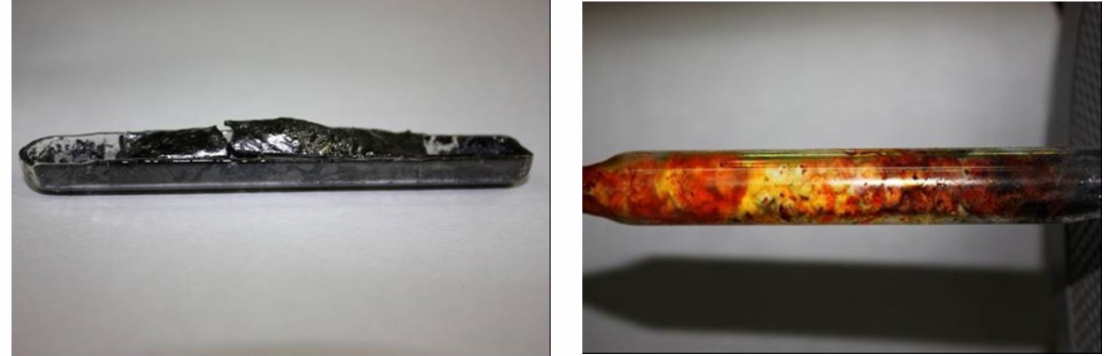
Figure 15. Quartz boat and reactor tube after pyrolysis of RW in tubular reactor at 600 ◦ C.